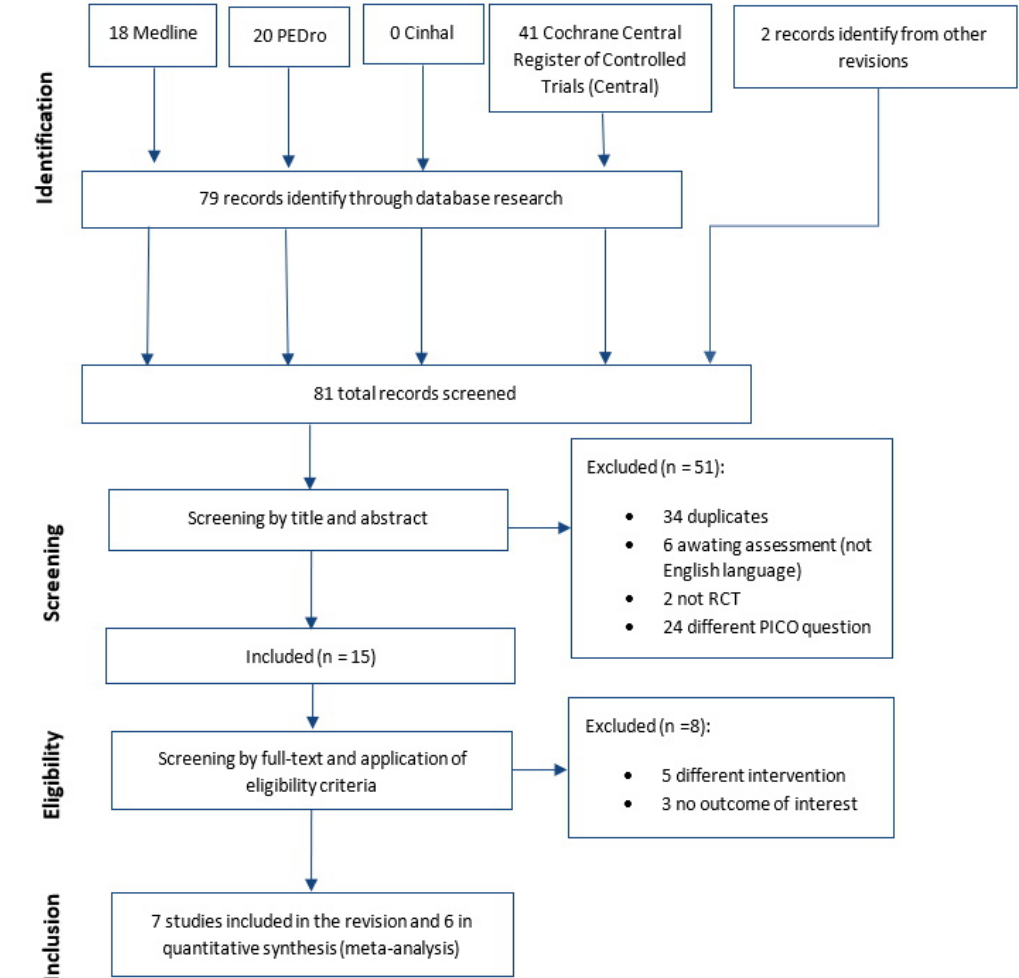
Figure 1. Study flow diagram. PEDro = Physiotherapy Evidence Database; RCT: Randomized controlled trial; PICO = population, intervention, comparison and